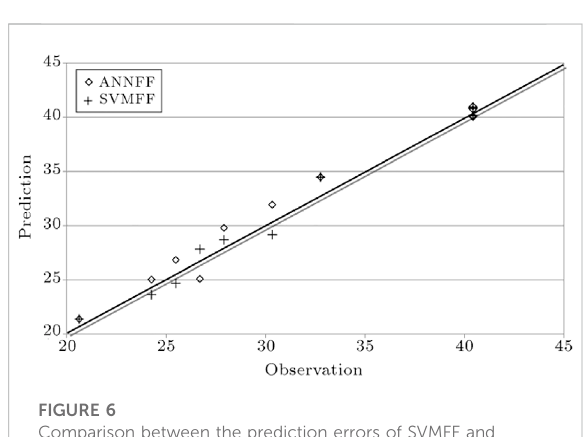
FIGURE 6 Comparison between the prediction errors of SVMFF and ANNFF (Yao et al.,